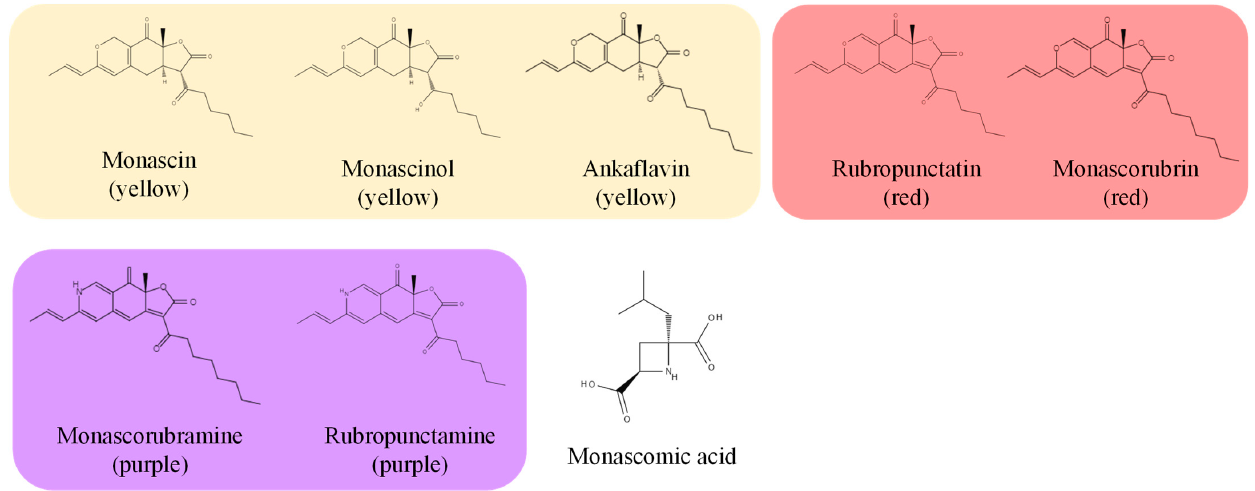
Figure 5. Major pigments (polyketides or azaphilone pigments) produced by Monascus fungi. A potent inhibitor of cholesterol synthesis, monacolin K (lovastatin) was discovered in 1979 in a strain of Monascus by Endo et al. [1–3,24]. Other active substances with a similar structure to monacolin K have since been found (Figure 6) [25,26]. Monacolins have two forms, acid or lactone form, depending on the conditions of the solution, particularly the pH (Figure 7)